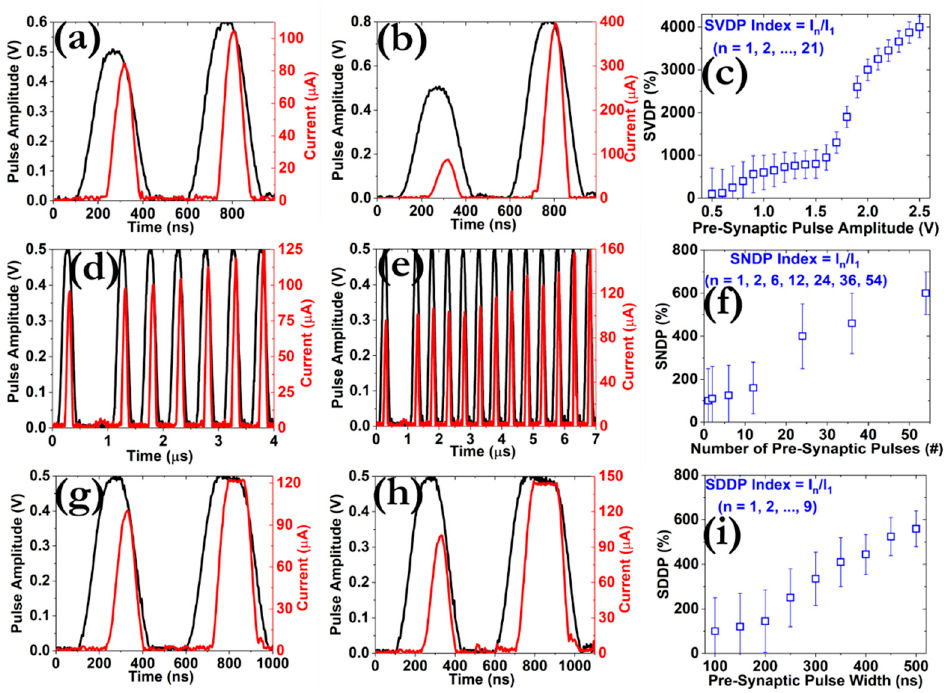
Figure 10. Demonstration of the PPF effect as a function of the amplitude between the pre-synaptic pulses. Twenty-one different pulse amplitudes were tested by applying two successive pulses of 100 ns width and delay time, while ( a ) and ( b ) depict the post-synaptic responses for pulse amplitude of 0.6 V and 0.8 V ns, respectively. The amplitude of the first pre-synaptic pulse was always kept constant at 0.5 V. ( c ) Distribution of the spike-voltage dependent plasticity (SVDP) index (I n /I 1 ) calculated by two consecutive pulses with amplitude 0.5 ≤ V p ≤ 2.5 V (I 1 , 1st post-synaptic current; I n , nth post-synaptic current, n = 1, 2, 3, …, 21). Demonstration of the PPF effect as a function of the number of pre-synaptic pulses. Seven different pulse sequences were tested by applying pulses of 0.5 V amplitude, 100 ns width and delay time, while ( d ) and ( e ) depict the post-synaptic responses by enforcing a total number of the pulse train of 6 and 12, respectively. The train of the pulses was enforced after the application of a single pulse of 0.5 V amplitude and 100 ns width, while the delay time was set to 1 μ s. ( f ) Distribution of the spike-number dependent plasticity (SNDP) index (I n /I 1 ) calculated by the number of spikes (n = 1, 2, 6, 12, 24, 36, 54). Demonstration of the PPF effect as a function of the width of two consecutive pre-synaptic pulses. Nine different pulse durations were tested by applying pulses of 0.5 V amplitude and 100 ns delay time, while ( g ) and ( h ) depict the post-synaptic responses for a pulse width of 150 and 200 ns, respectively. The width of the first pulse was always kept constant at 100 ns. ( i ) Distribution of the spike-duration dependent plasticity (SDDP) index (I n /I 1 ) calculated by the number of spikes (n = 1, 2, 3, …, 9).